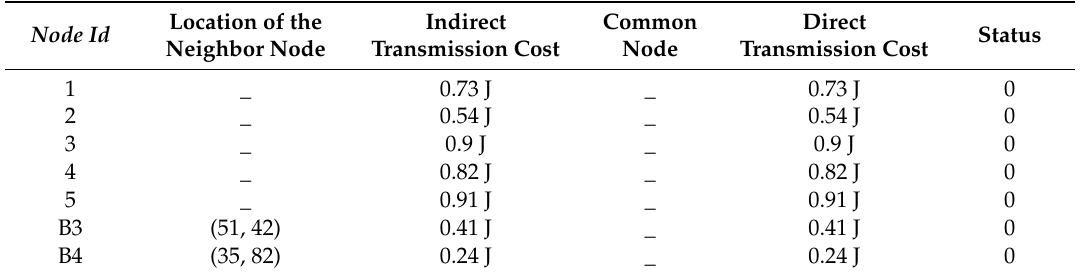
Table 2. Vicinity table of node B1 after all neighbor nodes